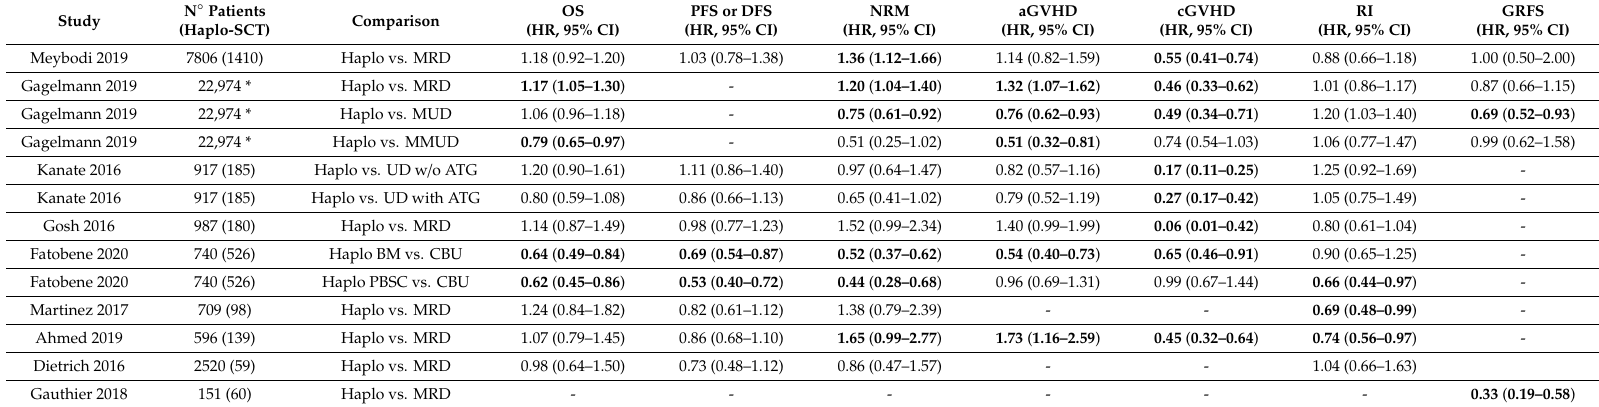
Table legend: Haplo-SCT: haploidentical stem cell transplantation; MRD: matched related donor transplant; MUD: matched unrelated donor transplant; MMUD: mismatched unrelated donor transplant; UD: unrelated donor transplant; CBU: cord blood unit transplant; BM: bone marrow; PBSC: peripheral blood stem cells; HR: hazard ratio; OS: overall survival; PFS: progression free survival; DFS: disease free survival; NRM: non-relapse mortality; aGVHD: grade IIi–IV acute graft-versus-host-disease, cGVHD: chronic graft-versus-host-disease either mild-moderate-severe or moderate-severe according to di ff erent publications; RI: relapse incidence; GRFS: GVHD / relapse-free survival; * total number of patients, n ◦ of Haplo-SCT varies according to explored outcome. Bold indicates statistically significant di ff erences between graft